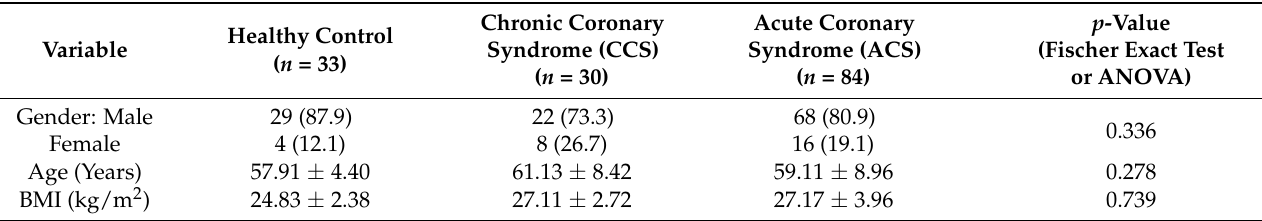
Table 1. Demographical characteristic of CAD patients in both groups and healthy controls. Descriptive data are presented as number (percentage) or mean